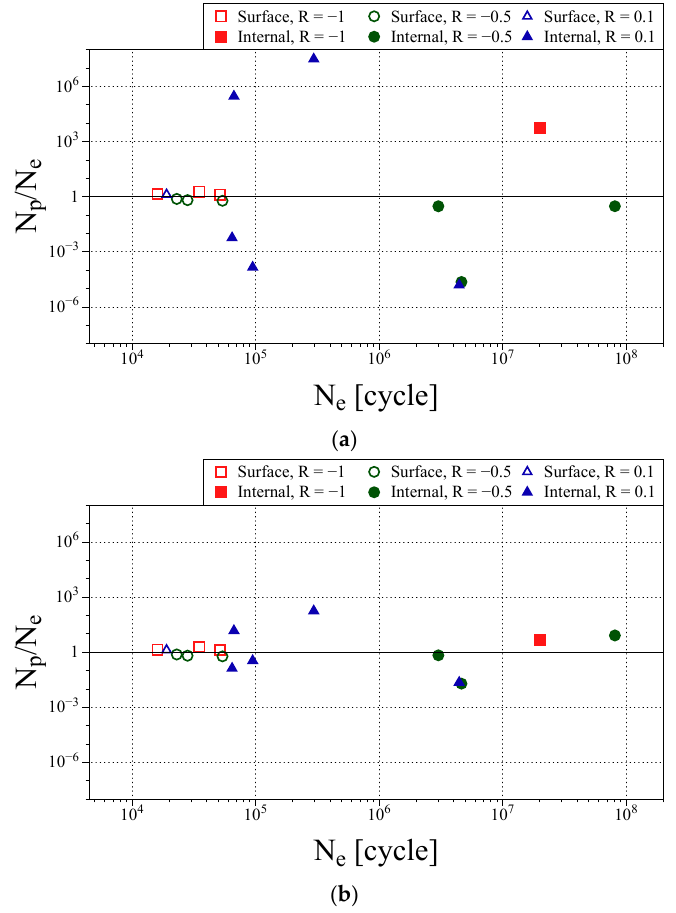
Figure 13. Relationship between the predicted and experimental fatigue life ( N p / N e ). ( a ) Using total facets area; ( b ) Using major facet area.